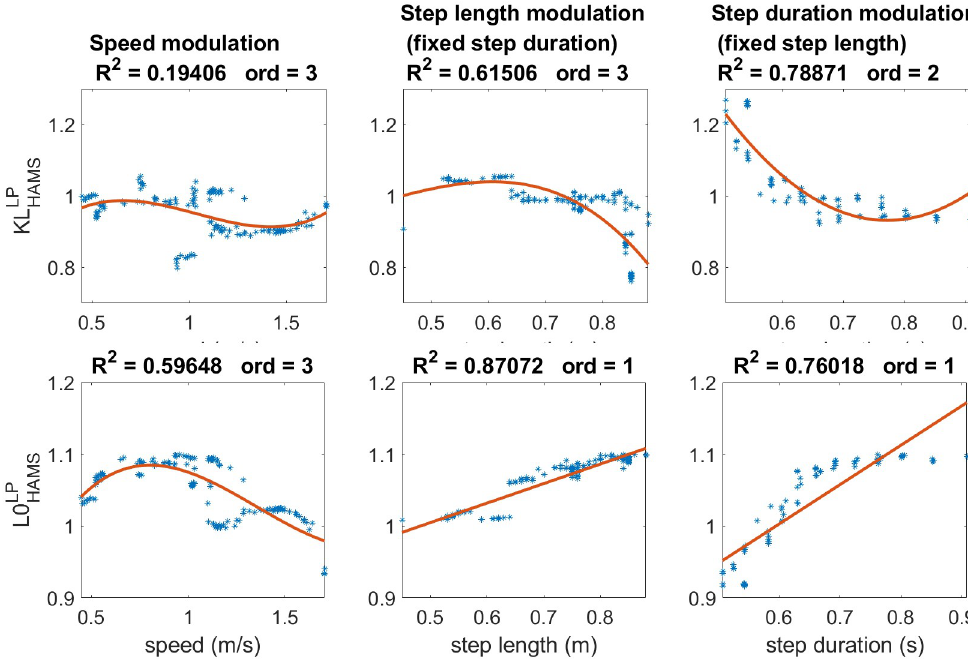
Fig 4. Regression analysis of step length and step duration modulators with effects on speed. Increasing the stretch reflex gain of hamstrings during landing preparation leads to a decreasing in step length and step duration resulting in a low influence in speed modulation. Similarly, the increasing length offset of hamstrings’ stretch relfex during landing preparation results in an increased step length and step duration with a small effect on speed